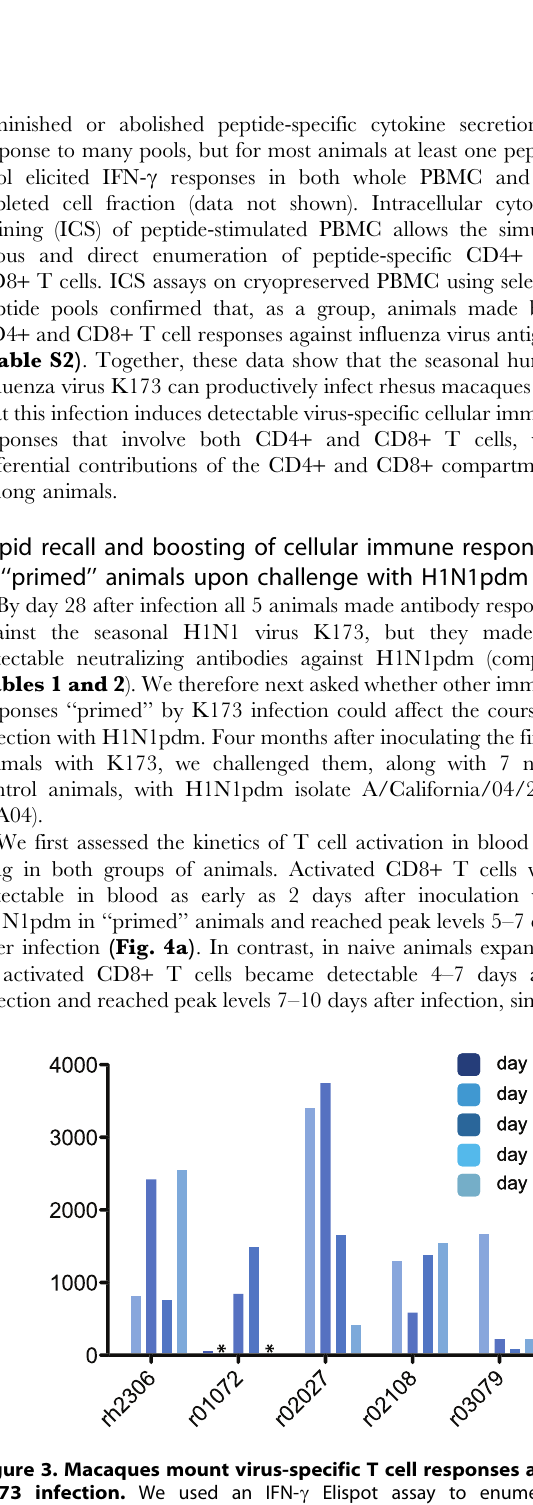
Figure 3. Macaques mount virus-specific T cell responses after K173 infection. We used an IFN- c Elispot assay to enumerate influenza virus-specific T cells among the peripheral blood mononuclear cells (PBMC) of infected macaques. PBMC were stimulated with 19 pools of overlapping synthetic peptides that collectively represented the influenza virus proteome, as described in the text. After subtracting background signal from the results for each pool, the frequency of cells responding to each pool were summed to give the total virus-specific response magnitude. Results are expressed as the number of spot- forming cells (SFC) per million PBMC. To be considered positive, the frequency of peptide-specific SFC/million PBMC must be at least 3 times larger than the background (no peptide) value. Asterisks indicate that data are not available from animal r01072 from days 7 or 21 post- inoculation due to technical problems.